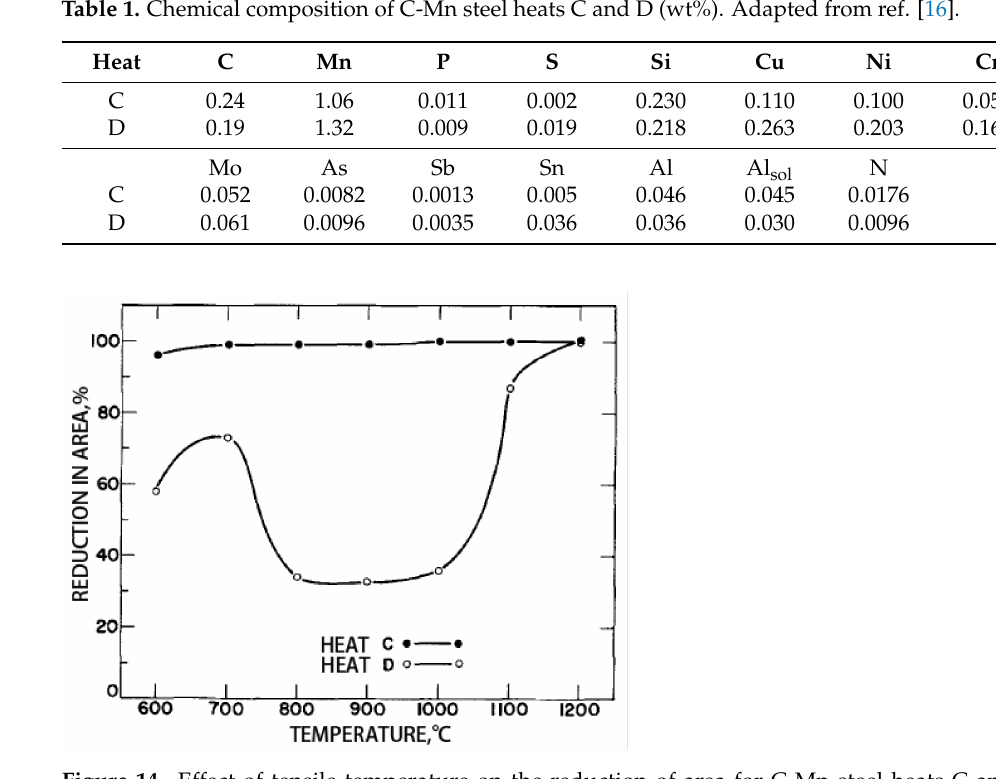
Figure 14. Effect of tensile temperature on the reduction of area for C-Mn steel heats C and D. Reprinted with permission from ref. [16]. Copyright 1969 Springer